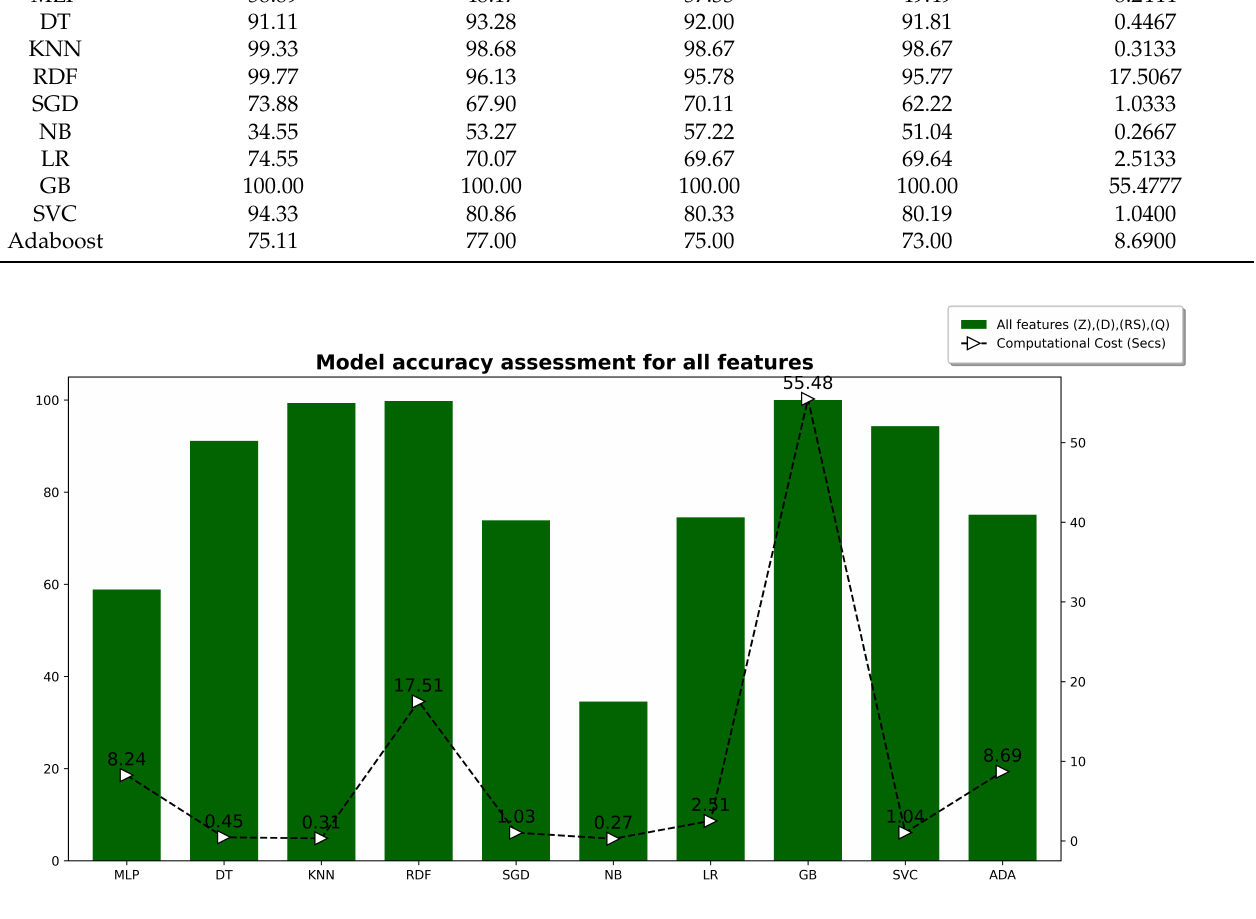
Figure 11. Model accuracy assessment for each all features